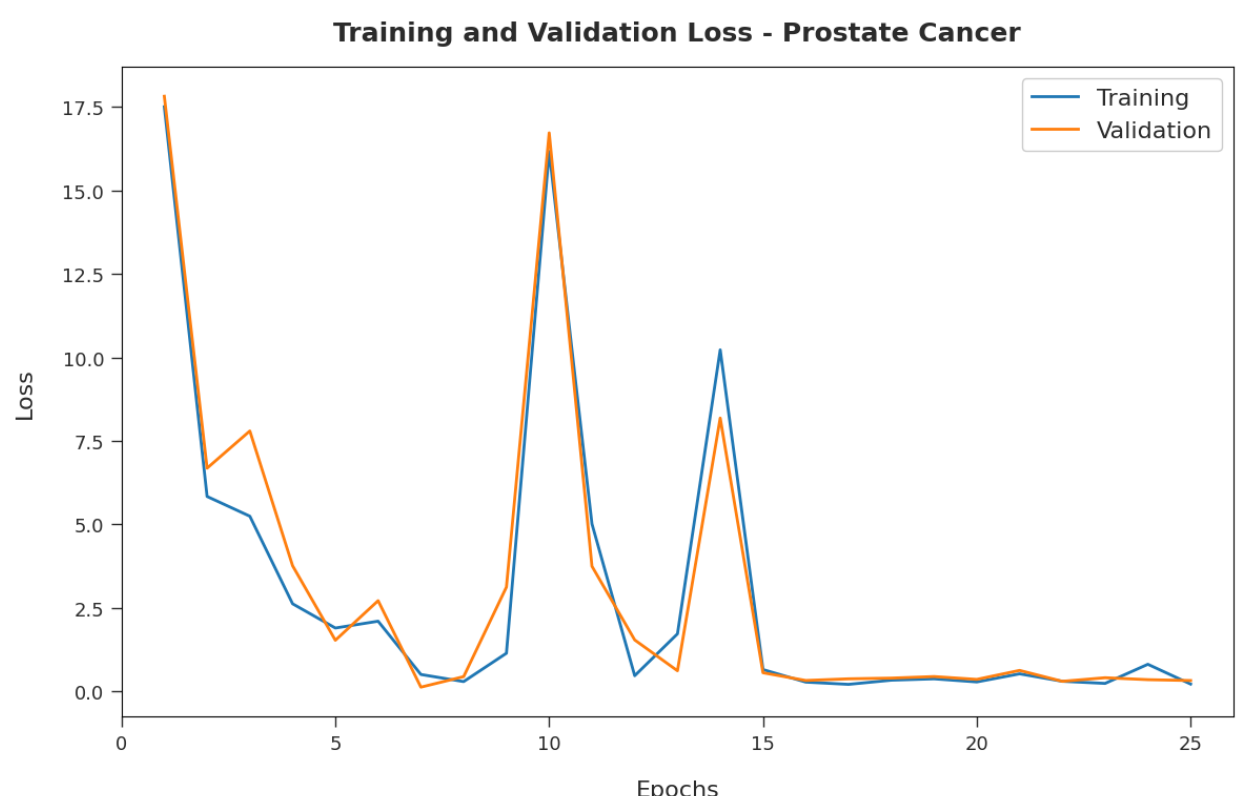
Figure 5. Loss analysis of RFODL-MGEC technique on prostate cancer dataset.